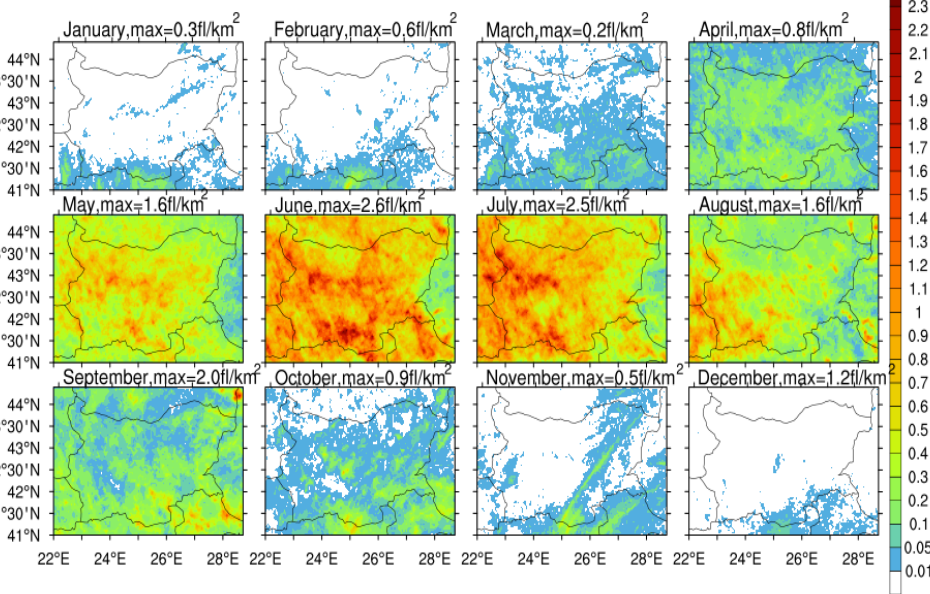
Figure 12. Box and whiskers plot of the number of days with detected flashes for the period 2012 – 2021 as a function of the average (on the grid of 0.05 × 0.05 deg) height in km.